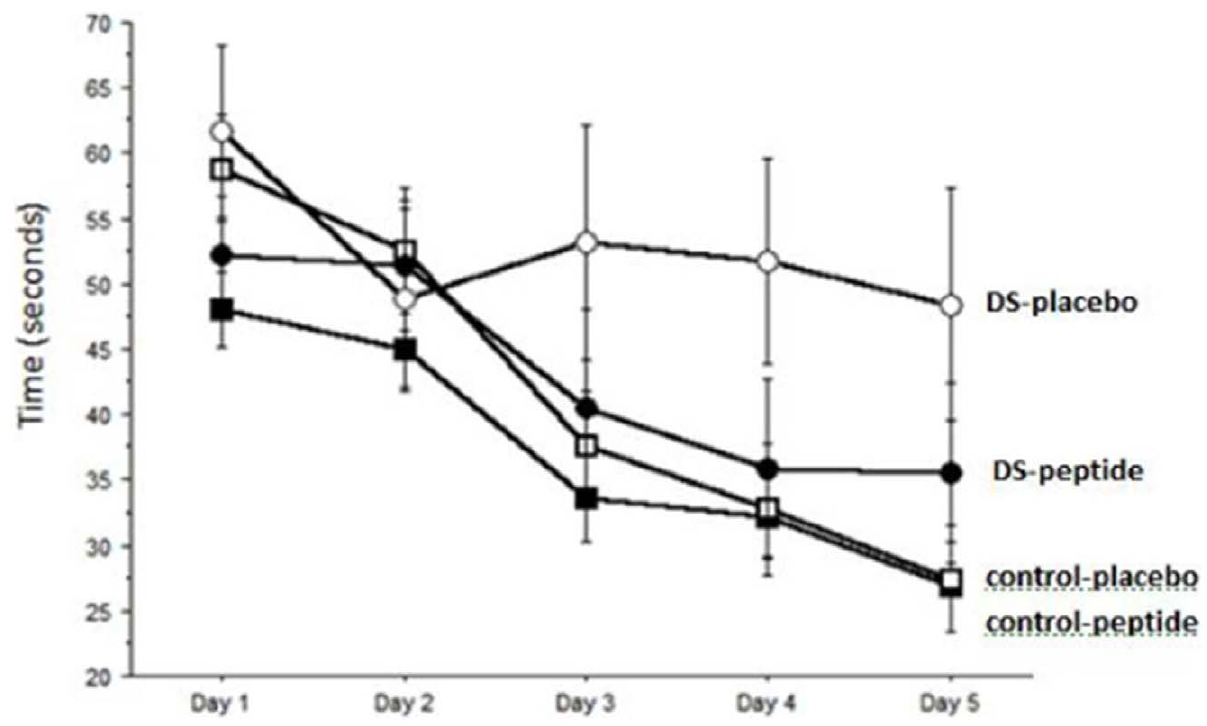
Figure 1. Assessment of spatial learning in the Morris watermaze. Learning was assessed by the latency in seconds to find the hidden platform. Animals with DS who prenatally received saline (placebo, open circles) did not learn over the 5 day period. Control animals (open squares) who prenatally received saline (placebo) did learn with an approximate halving of their latency. Control animals who prenatally received NAP + SAL (closed squares) also learned over the five day period. Animals with DS who prenatally received NAP + SAL (closed circles) learned over the five day period, similar to controls and significantly better than DS-placebo (p , 0.01).